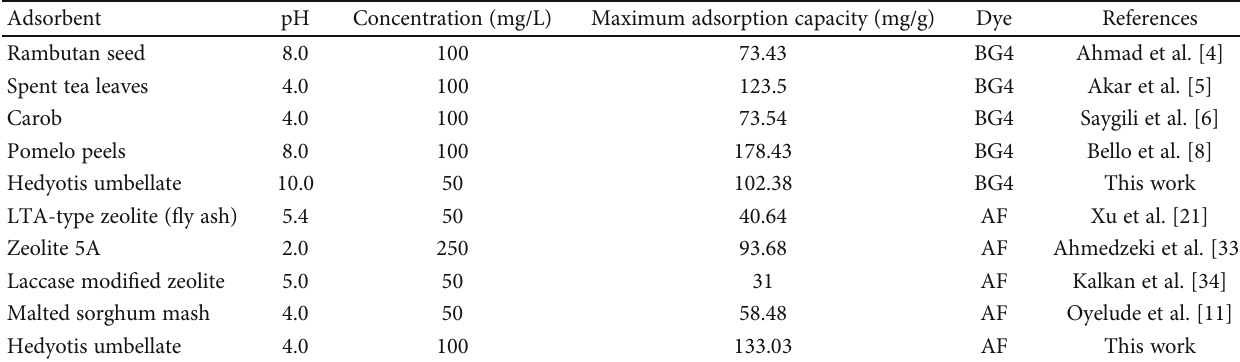
Table 6: Comparison of adsorption capacity of HUAC with other